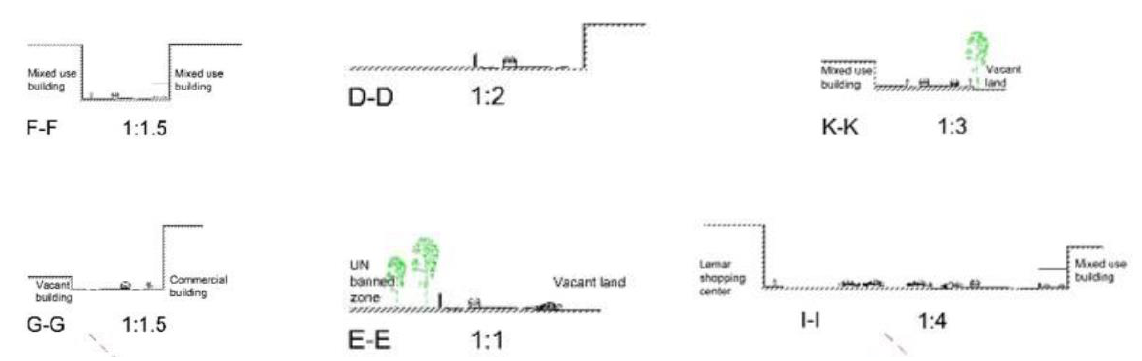
Figure10. Various street proportions in Salamis Road.